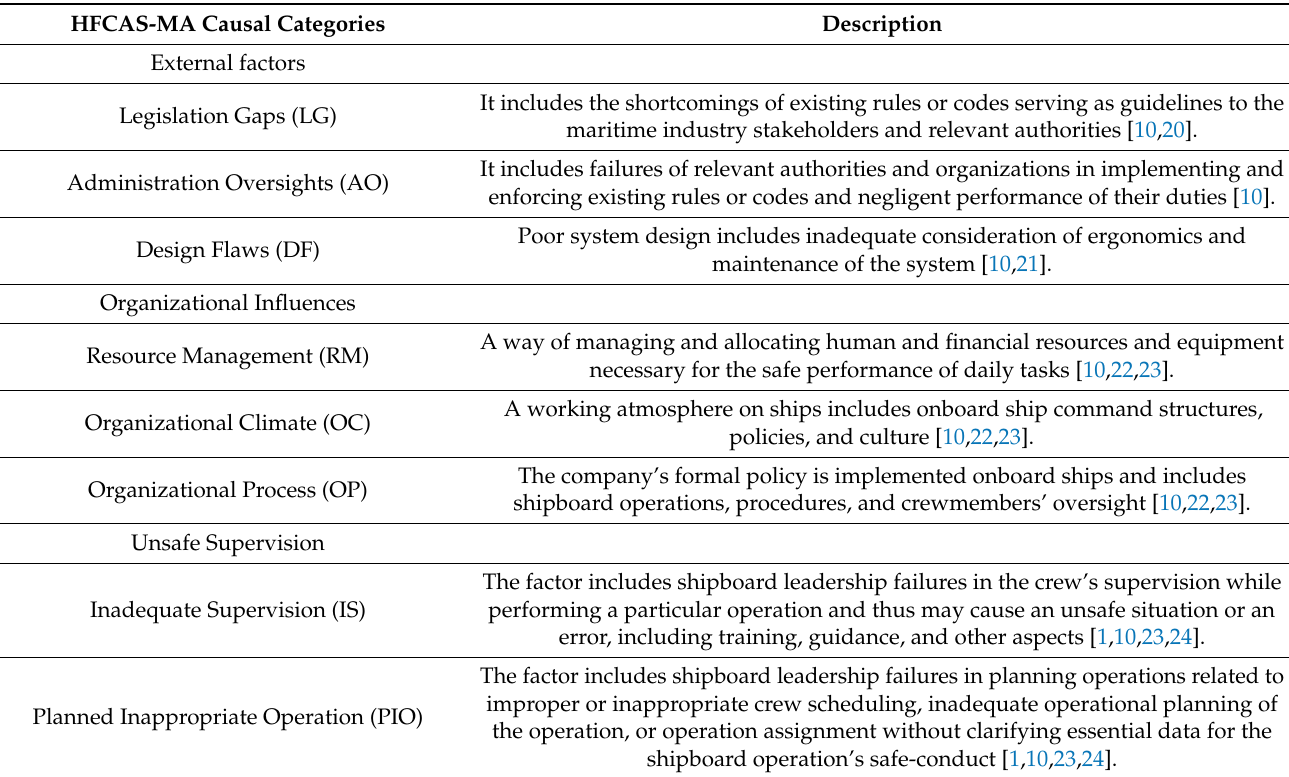
Table 1. Description of Human Factor Analysis and Classification System for Maritime Accidents (HFCAS-MA) causal